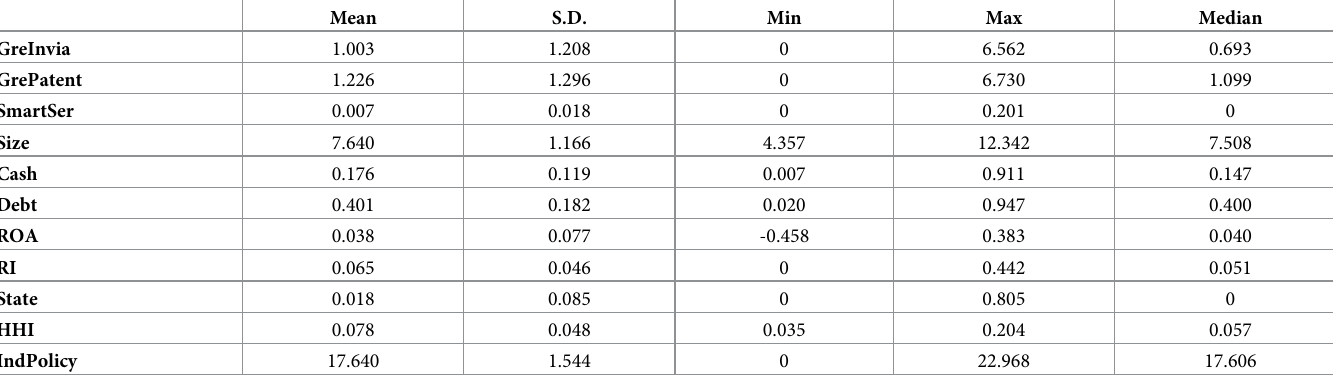
Table 3. Descriptive